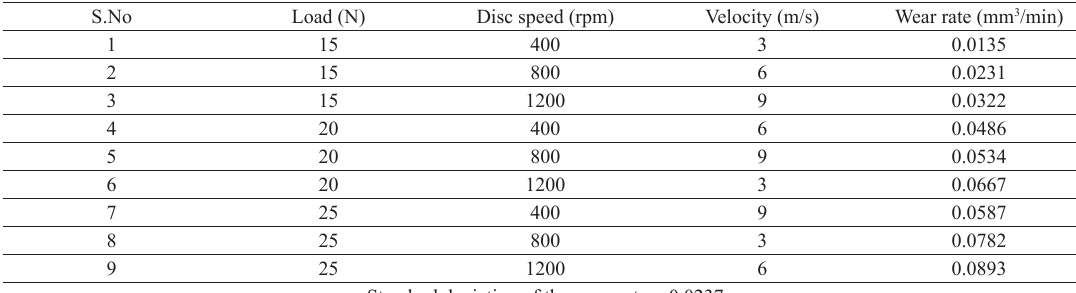
Table 1. Experimental results for wear rate of brass composite.